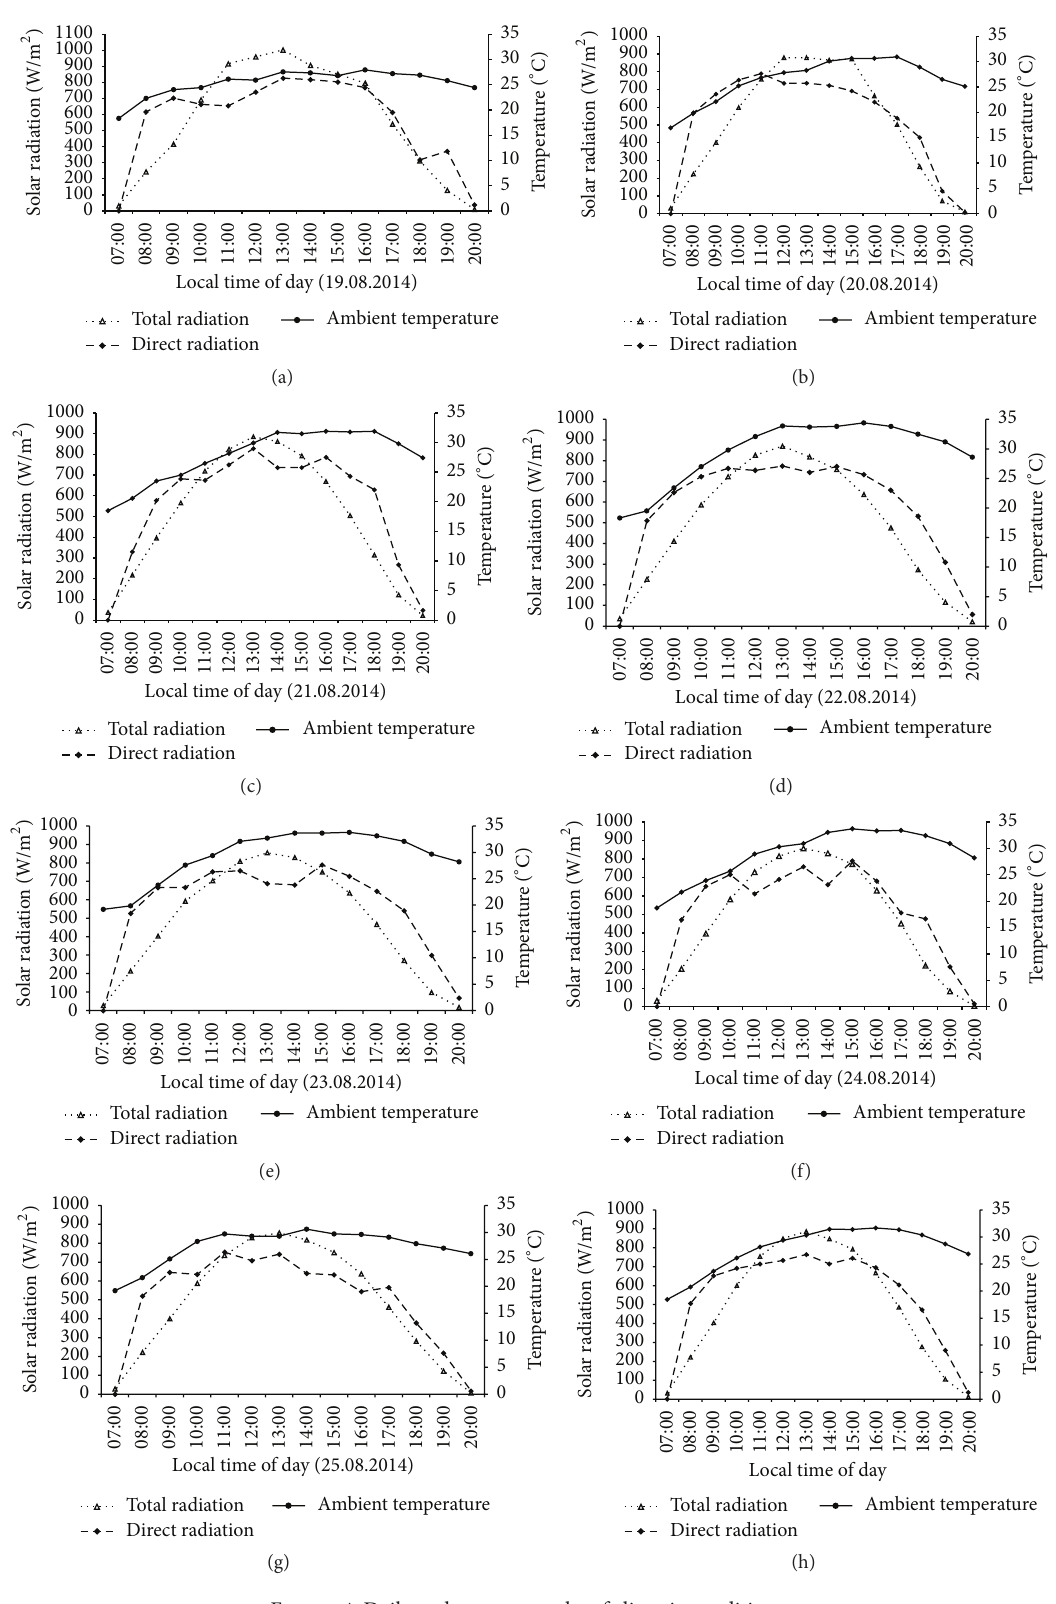
Figure 4: Daily and average results of climatic